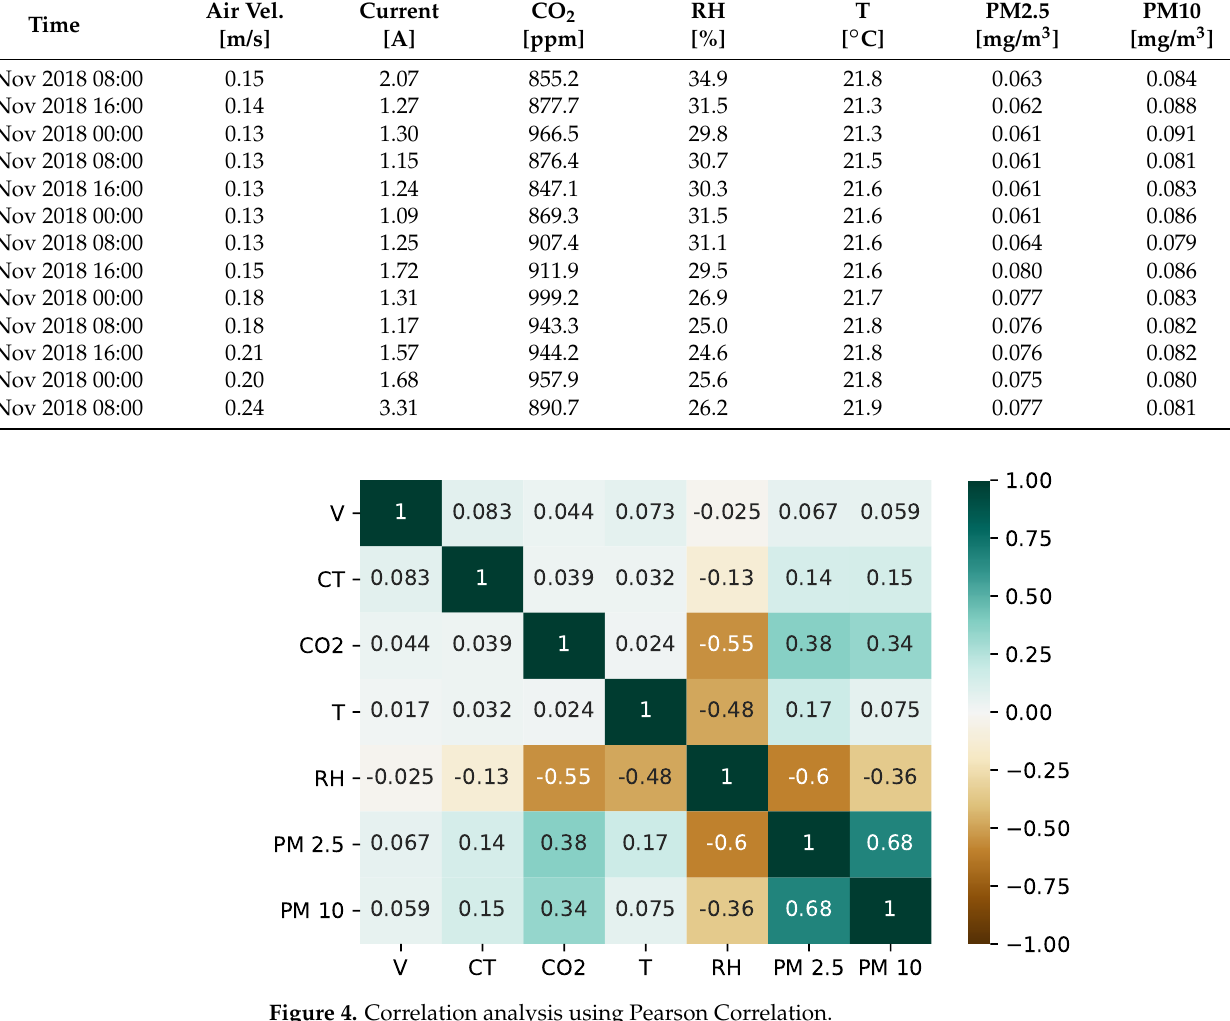
Figure 4. Correlation analysis using Pearson Correlation.